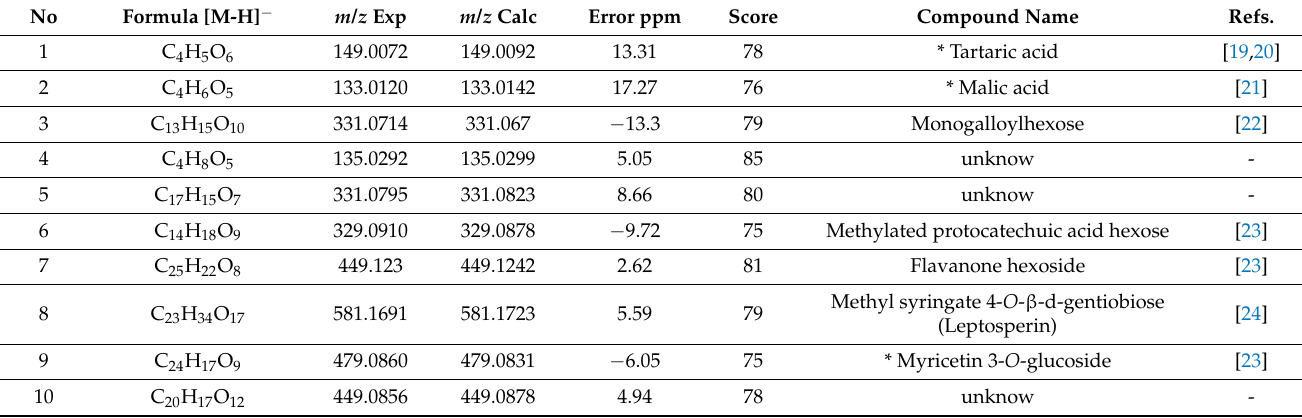
Table 1. Major constituents identified by HPLC/MS in tissues of P. ‘Endsleigh’ flowers at three developmental stages. No Formula [M-H]